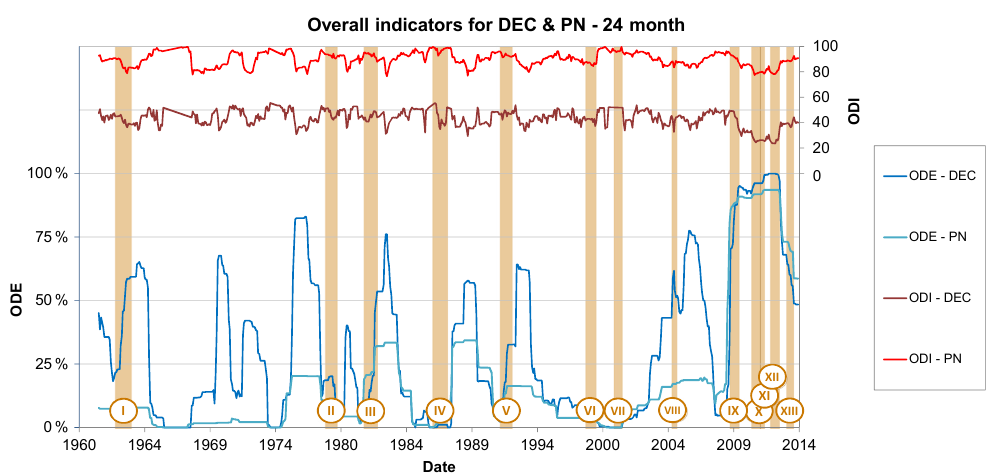
Figure A10. ODE and ODI values using the 24-month timescales of DEC and PN indices, compared with the 13 detected historical droughts (in